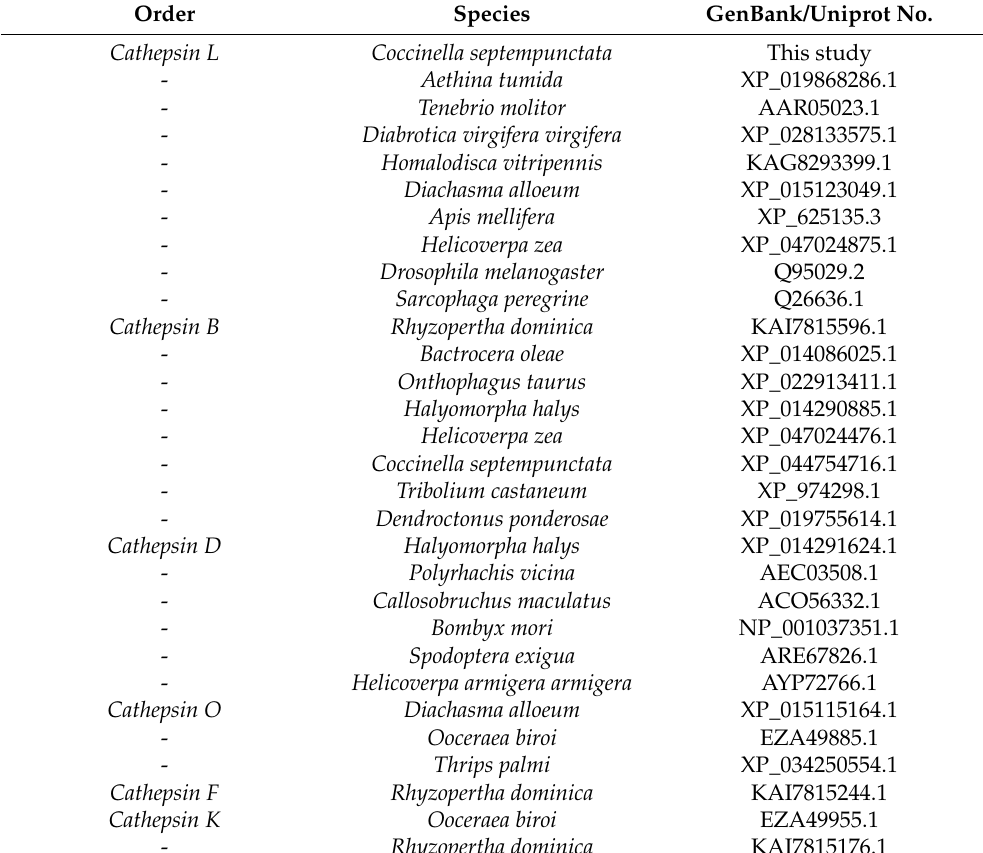
Table 2. Information on the insects included in the phylogenetic